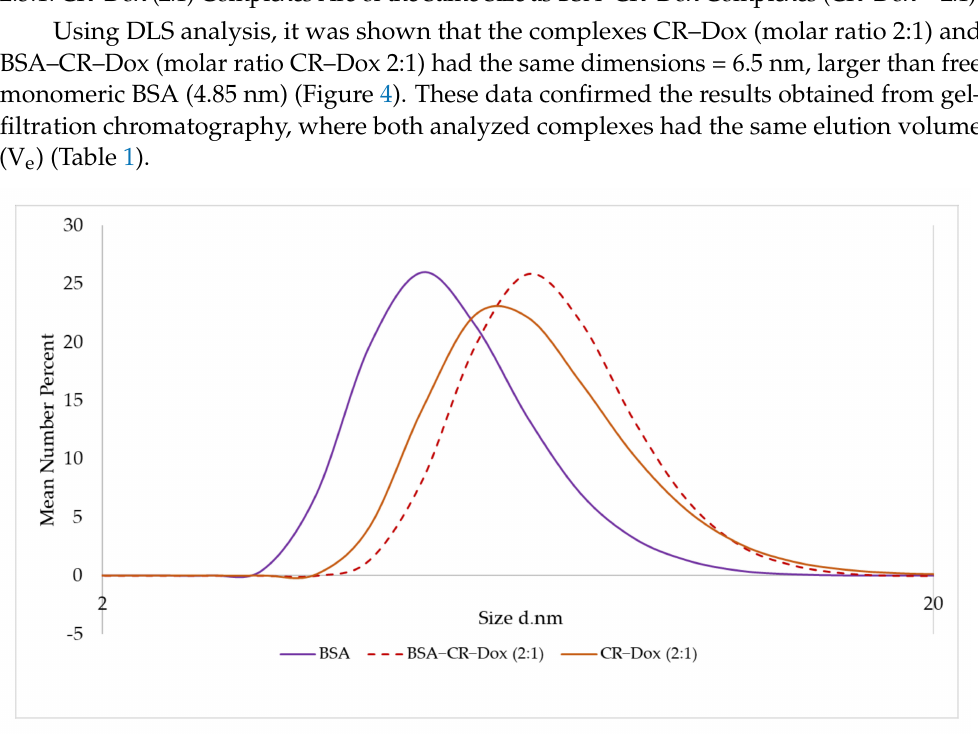
Figure 4. DLS analysis. Mean number (%). Hydrodynamic diameter distribution measurements: